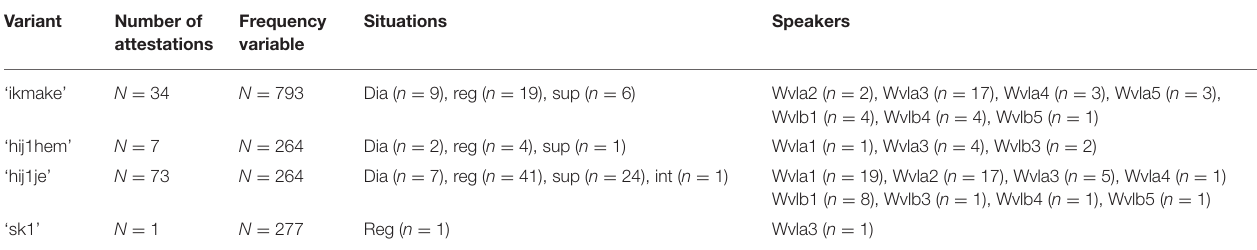
TABLE 1 | Absolute frequencies of the eastern West-Flemish non-standard, non-endogenous variants (brown cluster). Variant Number of Frequency Situations attestations variable